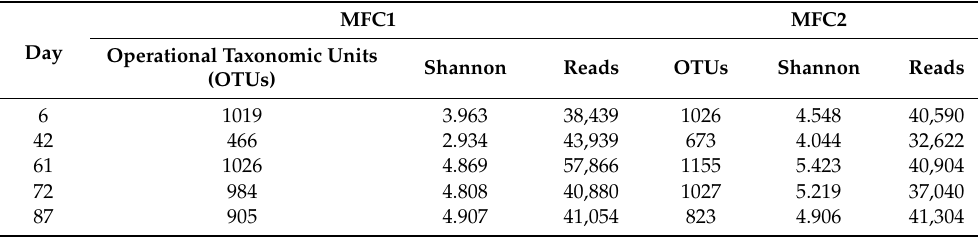
Table 1. Molecular indicators in Microbial Fuel Cell (MFC)1 and MFC2.